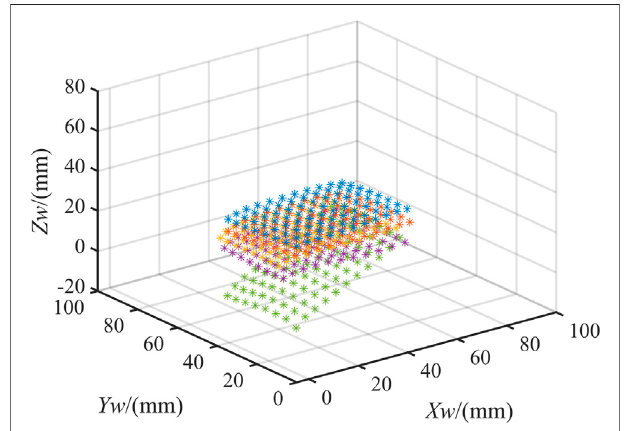
FIGURE 10 | Chessboard cornors reconstruction results.